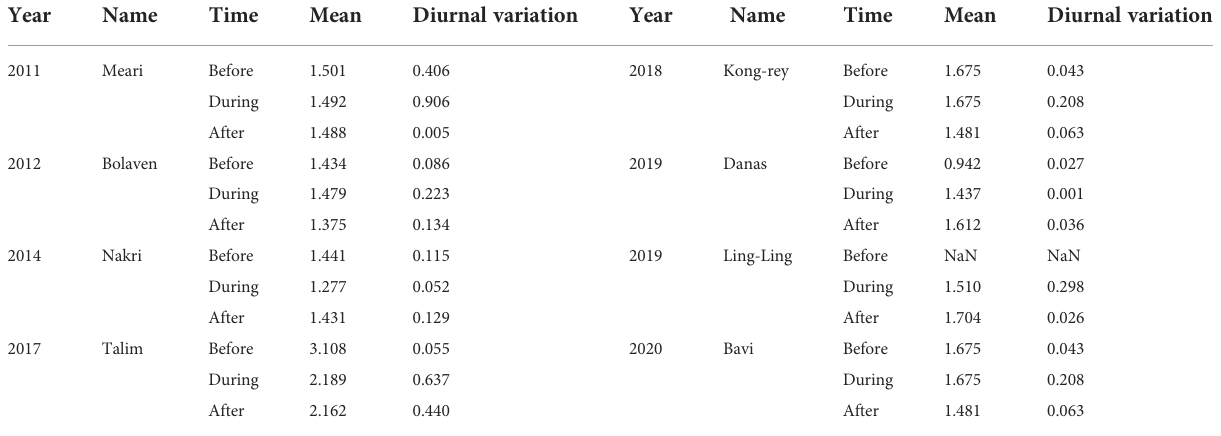
TABLE 2 Results at Nearshore Area in GOCI from 2011 to 2020.